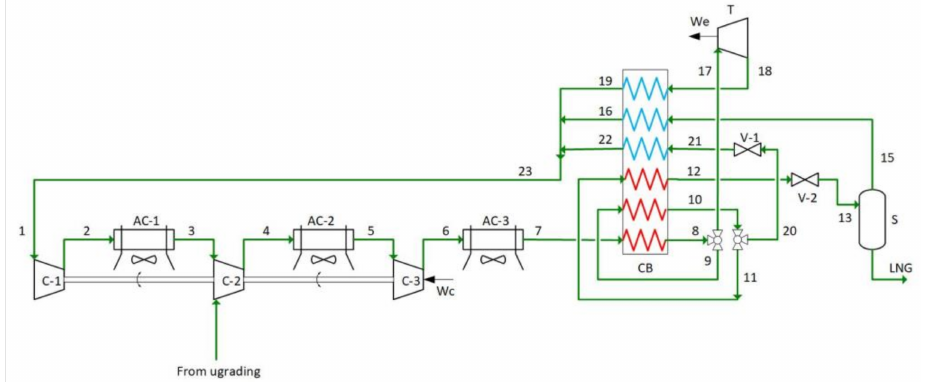
Figure 3. Kapitza process with secondary valve